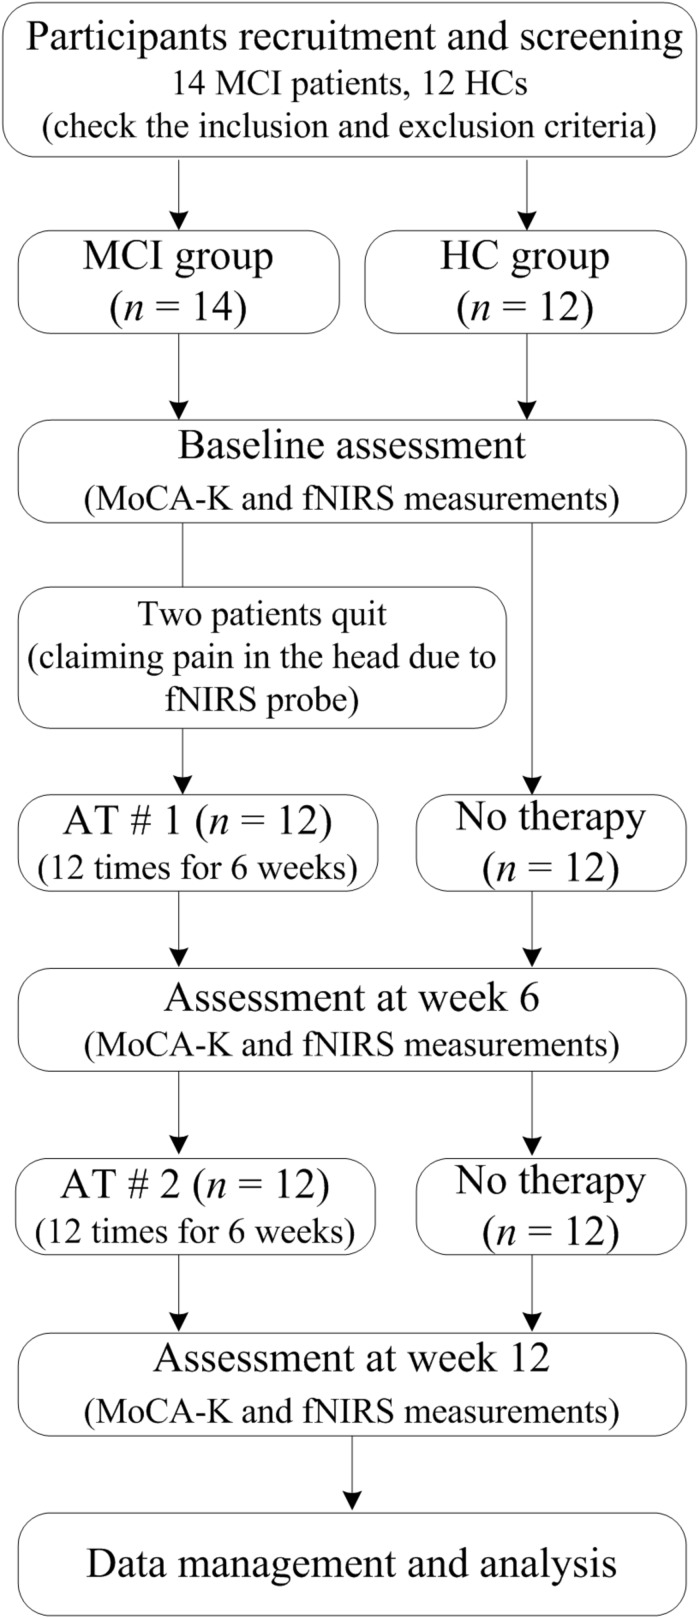
A flow diagram of the clinical study.